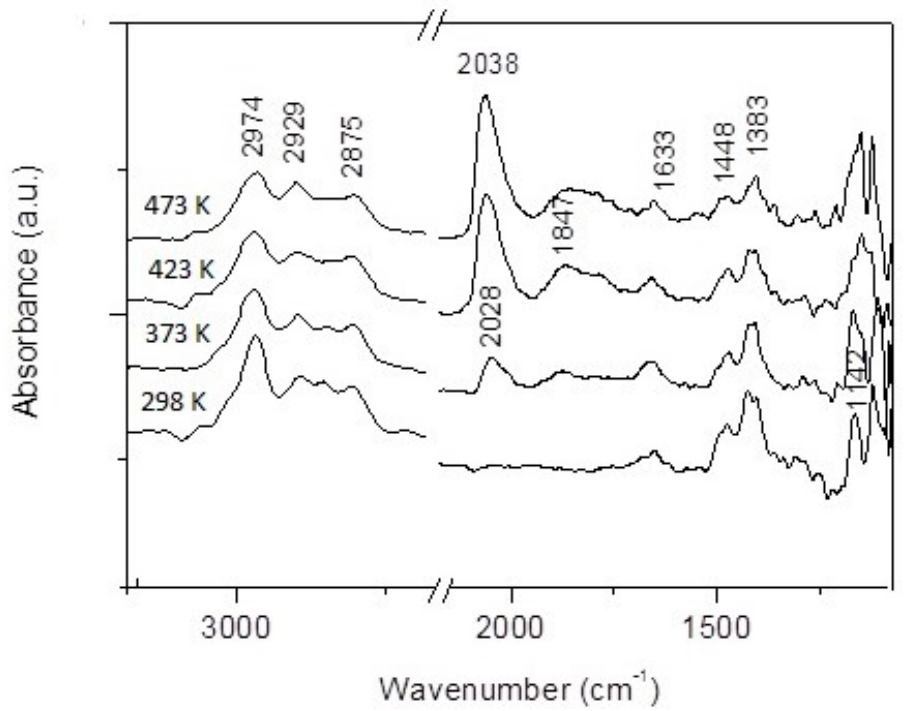
Figure 15. DRIFT spectra obtained on Rh/TiONW during ethanol decomposition at different temperatures.